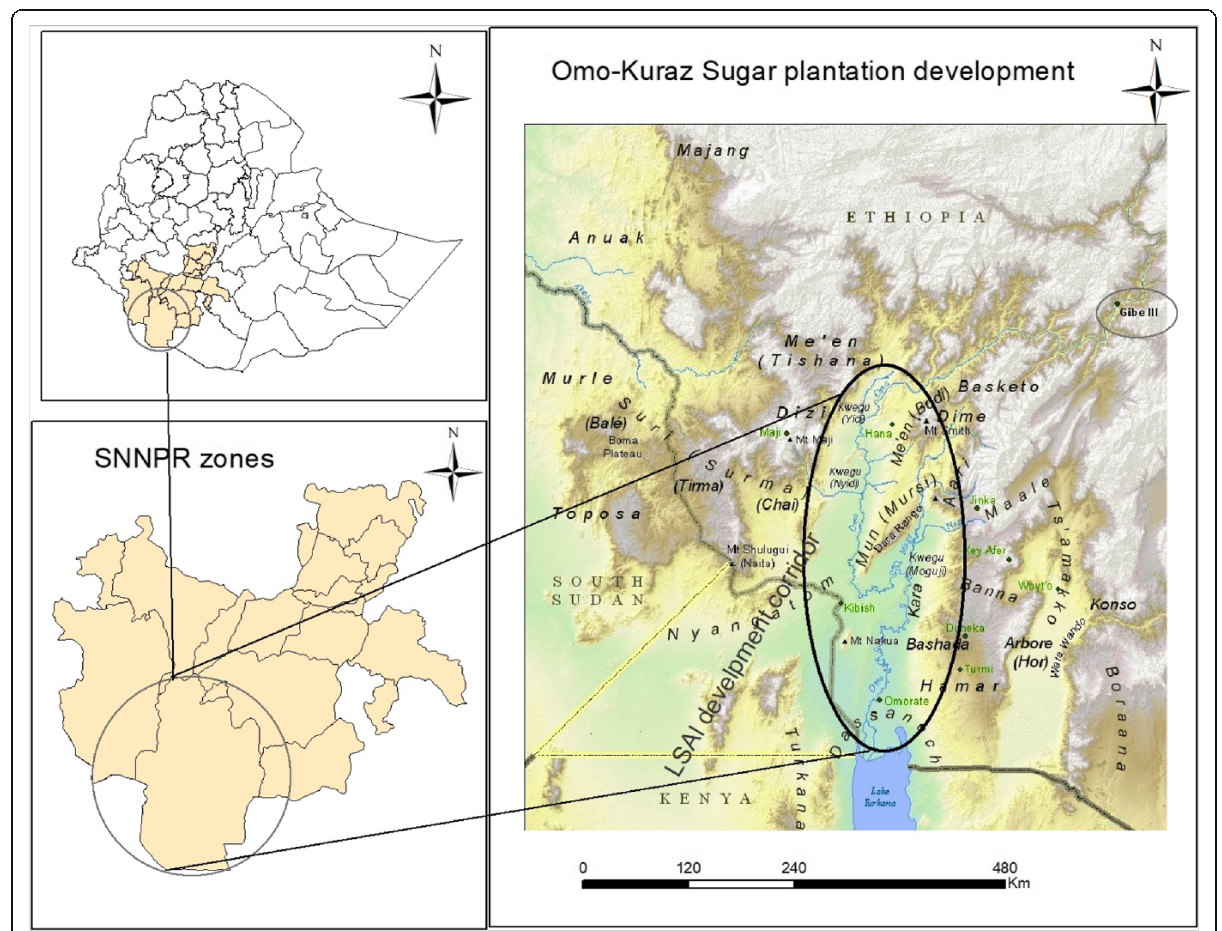
Fig. 1 Omo-Kuraz sugar plantation development area [source: authors, based on data available on ESRI]